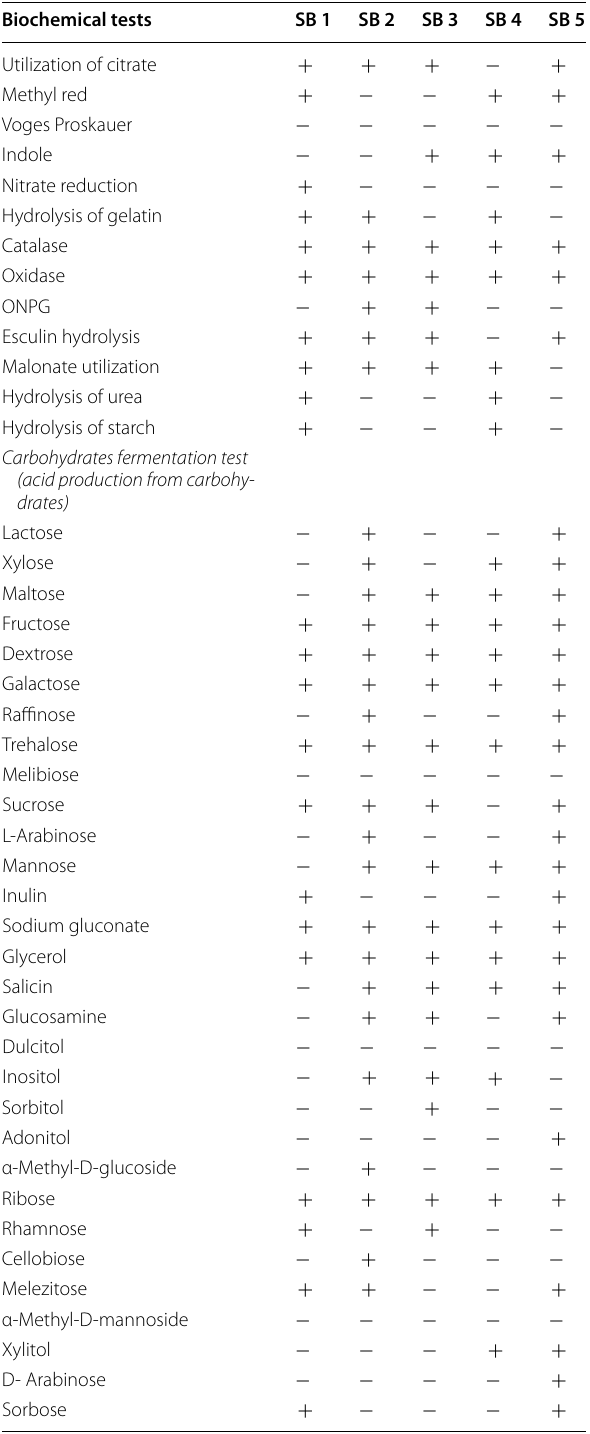
Table 3 Biochemical characterization of stress-tolerant bacteria isolated from soil samples (CSSRI, 24 South